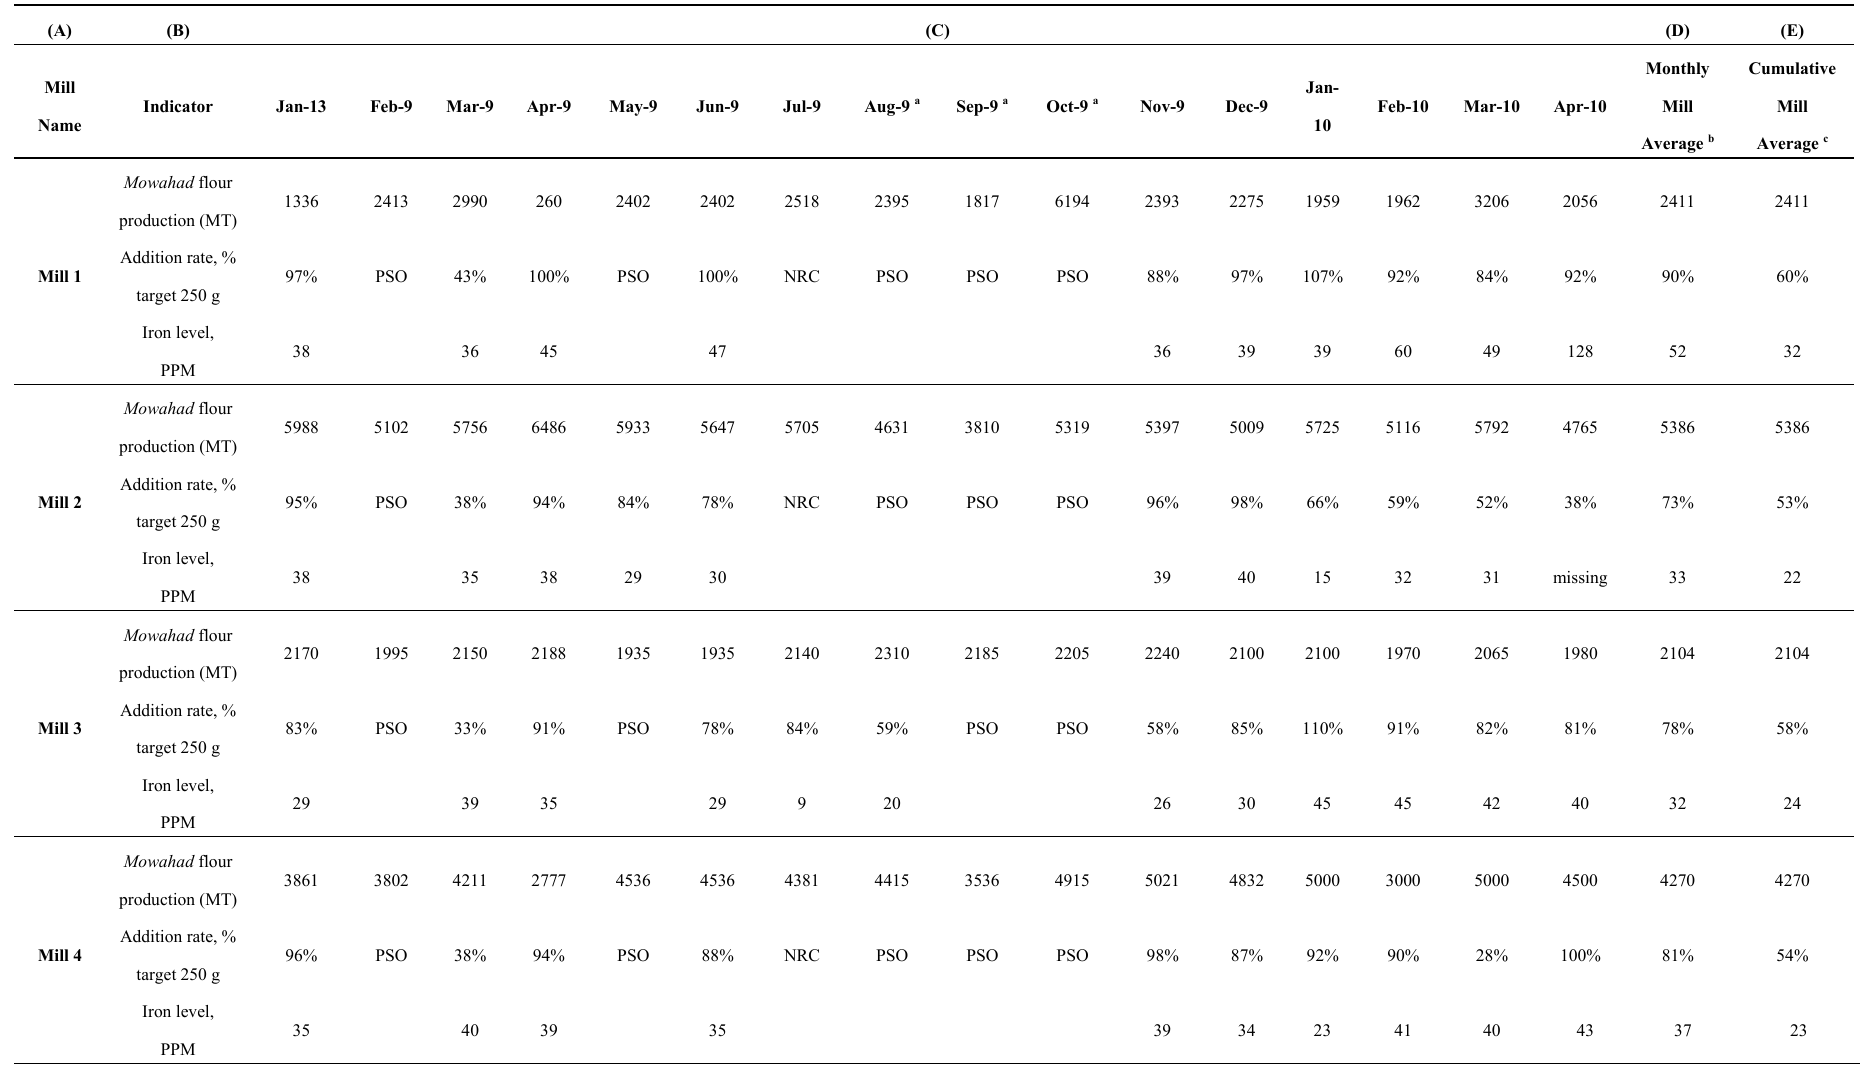
Table 4. Monthly mill monitoring results from January 2009 to April